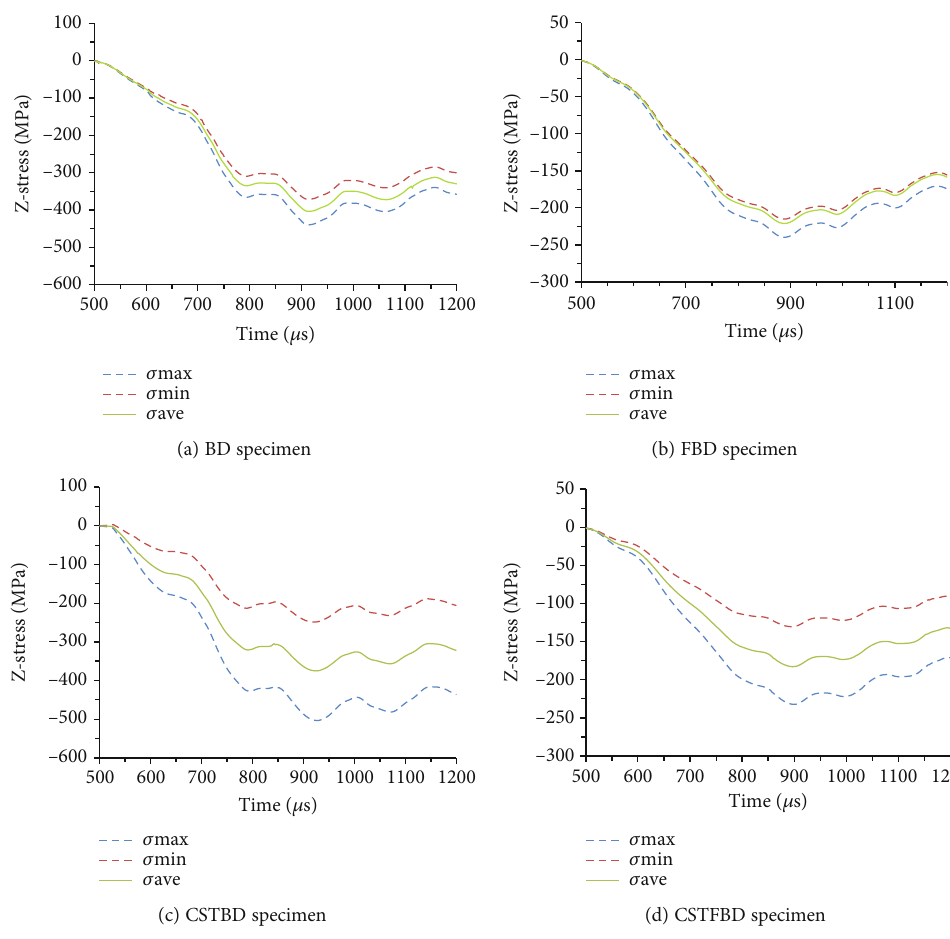
Figure 17: Stress analysis at di ff erent thicknesses of the loaded ligament section.